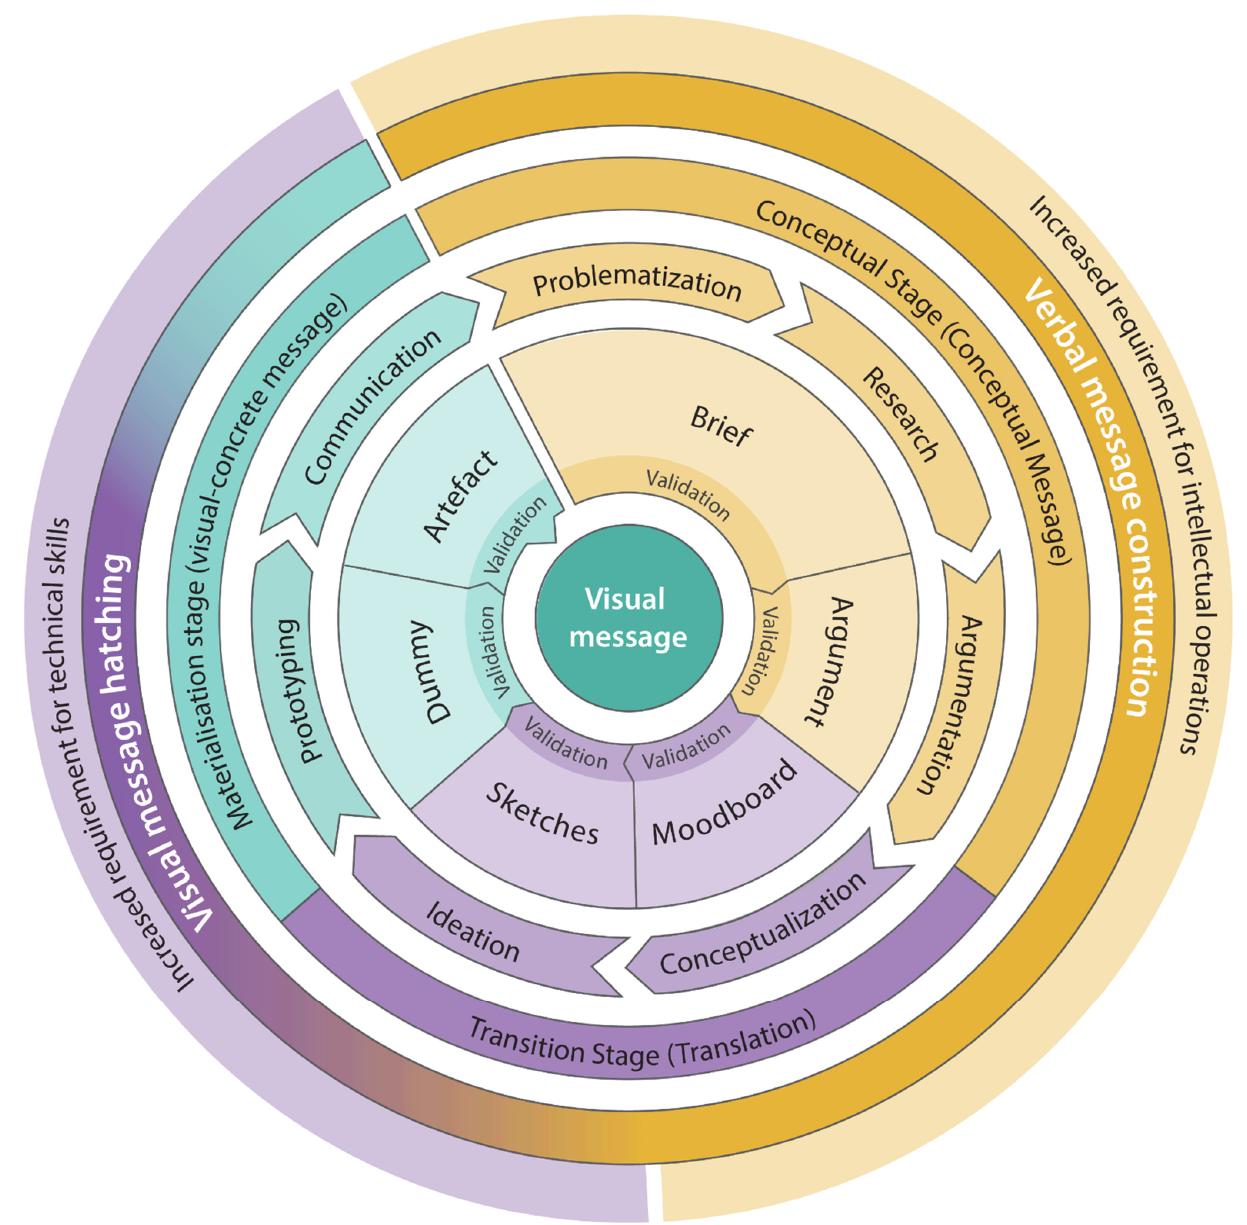
Figure 2. The model for persuasive design (own elaboration).